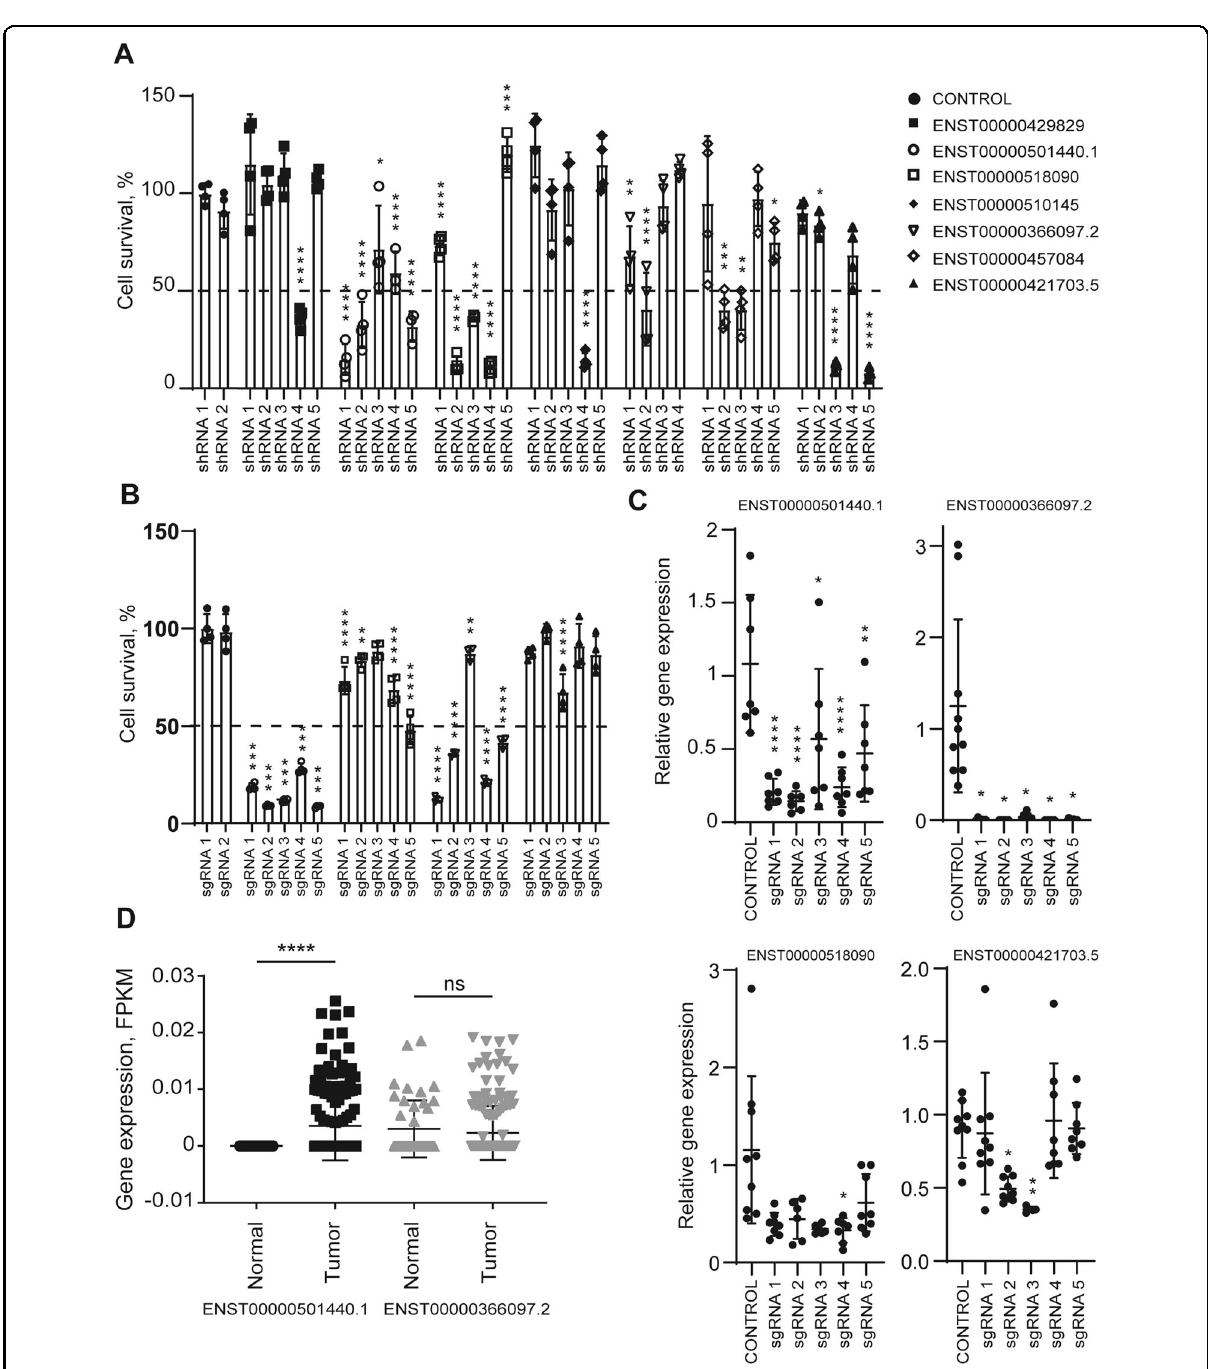
Fig. 2 Validation of the screen results identi fi es lncRNA ASTILCS a new regulator of HCC cell survival. A HUH7 cell survival upon shRNA- mediated knockdown of candidate lncRNAs (compared to control shRNA1), n ≥ 3. B HUH7 cell survival upon CRISPRi-mediated knockdown of lncRNA candidates from A compared to control sgRNA1, n ≥ 3. C LncRNA expression in HUH7 cells transduced with sgRNA-dCas9-KRAB targeting one of the lncRNA candidates, n ≥ 4. D ENST00000501440.1 (ASTILCS) and ENST00000366097.2 expression in HCC vs. adjacent tissue in patient samples (TCGA- LIHC-rnaexp downloaded from TANRIC), n ≥ 45. All values are mean ± SD, **** - p < 0.0001; *** - p < 0.001; ** - p < 0.01; * - p <